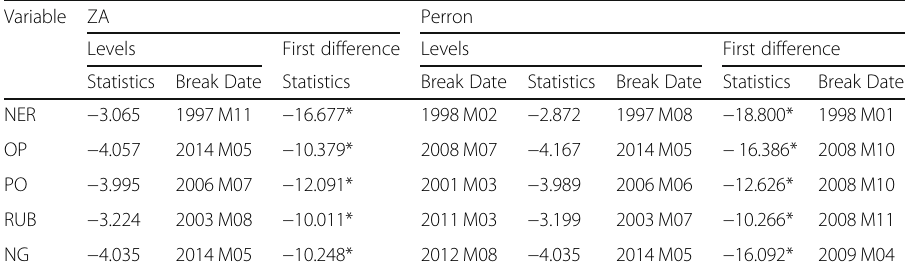
Table 4 Unit root test results Variable